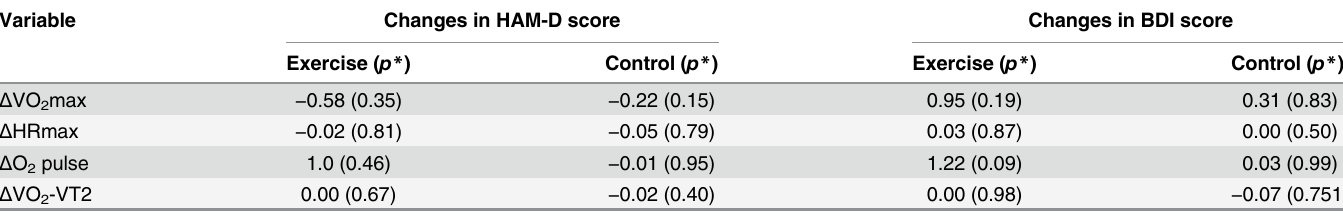
Table 2. Pearson ’ s correlation coefficients for clinical scores and cardiopulmonary